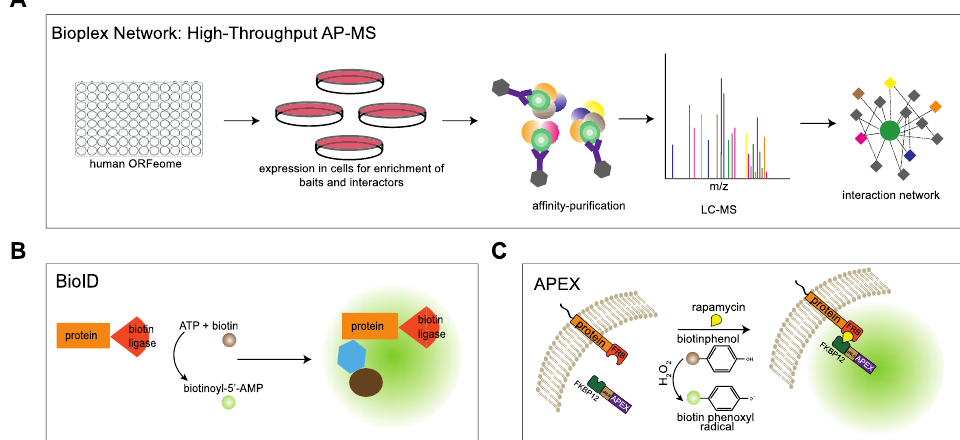
Figure 3. Approaches used to analyze the interactome of the VAPs. ( A ) Schematic of high-throughput interaction mapping using affinity-purification mass spectrometry. From the human ORFeome, a lentiviral library was created. The baits were expressed in HEK293T cells, subjected to affinity purification, and protein complexes were analyzed by LC-MS. All the interactors and baits were combined to generate a network of the human interactome [43]. ( B ) In a BioID approach, the protein of interest is tagged with biotin ligase and expressed in cells. The enzyme converts free biotin into reactive biotinoyl-5′-AMP, which reacts with primary amines of proximal proteins. The biotinylated proteins are enriched and identified using mass spectrometry [59]. ( C ) In APEX-based proximity labelling, the protein of interest is fused to ascorbate peroxidase (APEX). In the presence of H 2 O 2 , APEX converts biotin phenol into biotin phenoxyl radicals, which covalently label proteins in close proximity. In RAPIDS, the specific subcellular interactome of VAPB was analyzed by using rapamycin induced dimerization of FKBP12- and FRB-containing fusion proteins, followed by APEX2-dependent biotinylation of proteins and their identification by MS [60]. In this approach, SILAC allows a direct comparison between plus- and minus-rapamycin conditions and, thus, a very efficient elimination of the background.